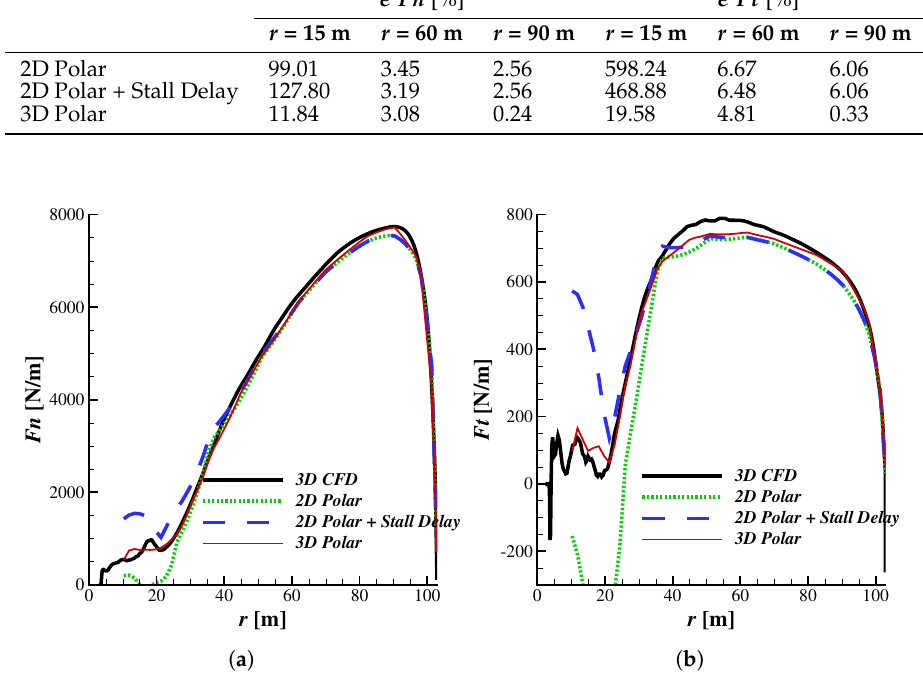
Figure 8. Effects of various polar datasets on the accuracy of BEM predictions; ( a ) normal force, ( b ) tangential force.